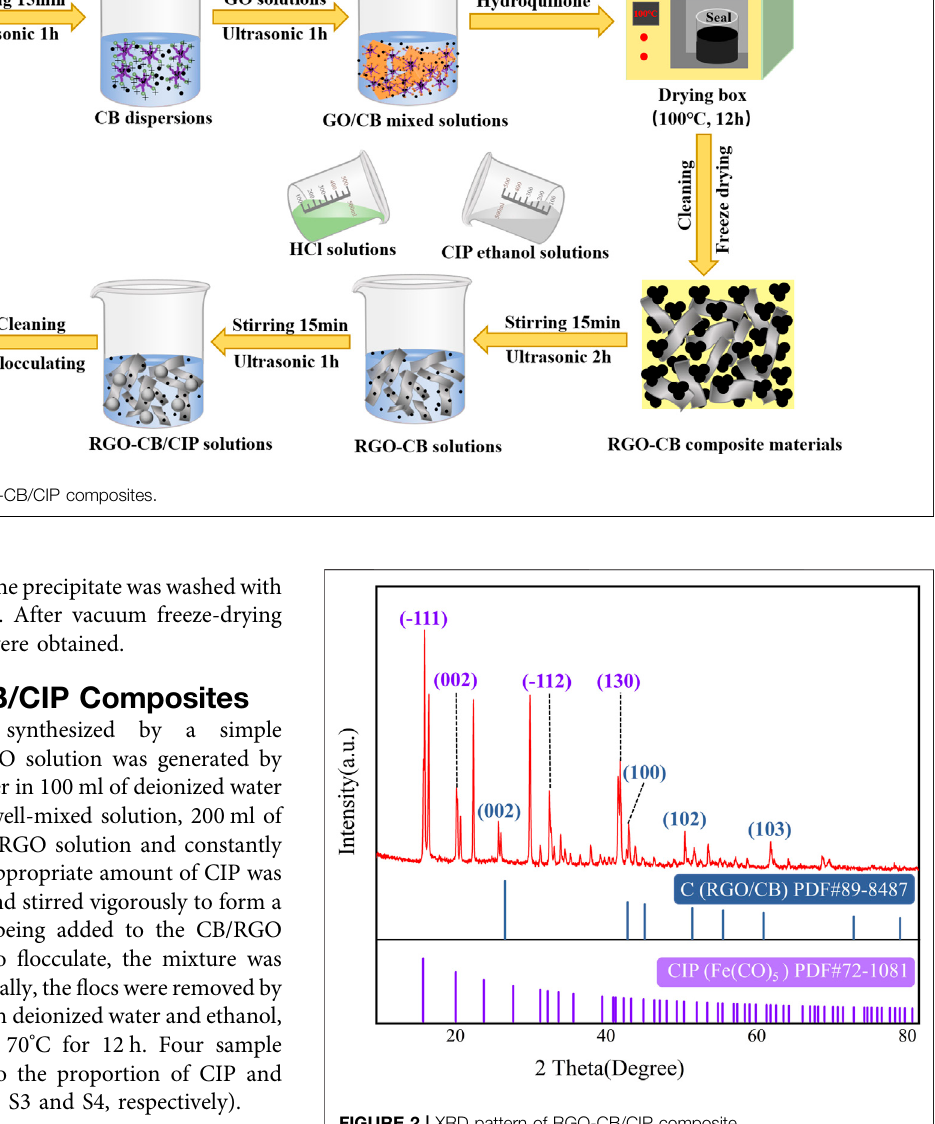
FIGURE 2 | XRD pattern of RGO-CB/CIP